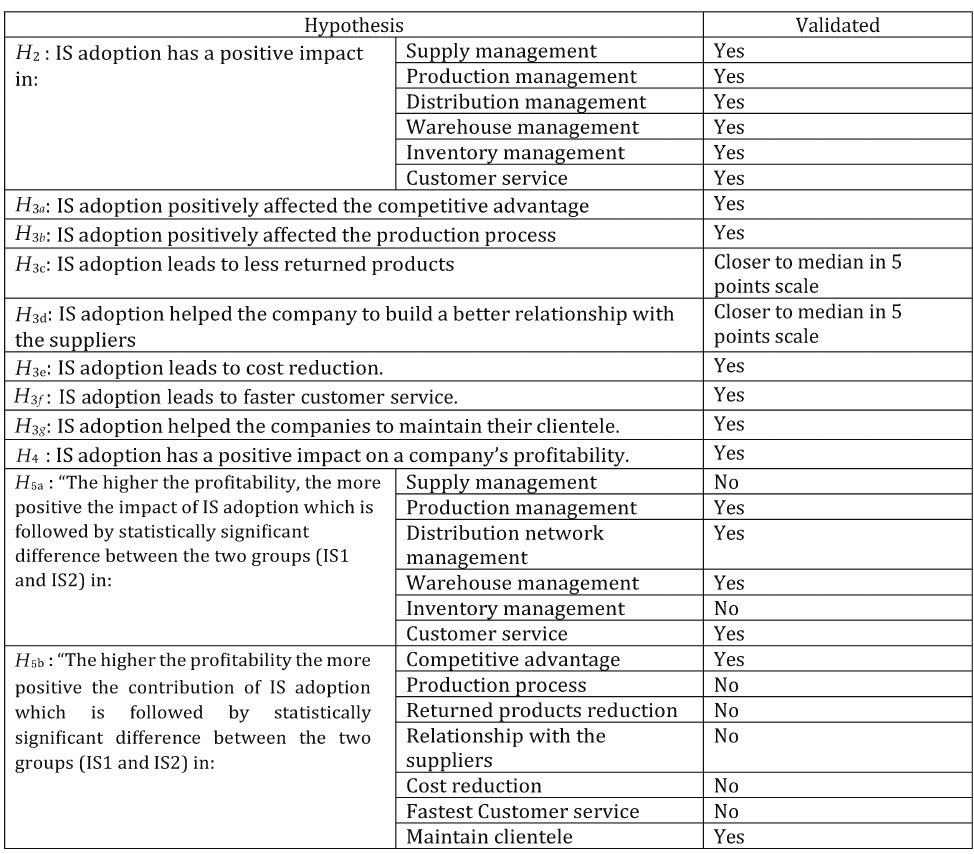
Figure 7. The hypotheses presented and their validation